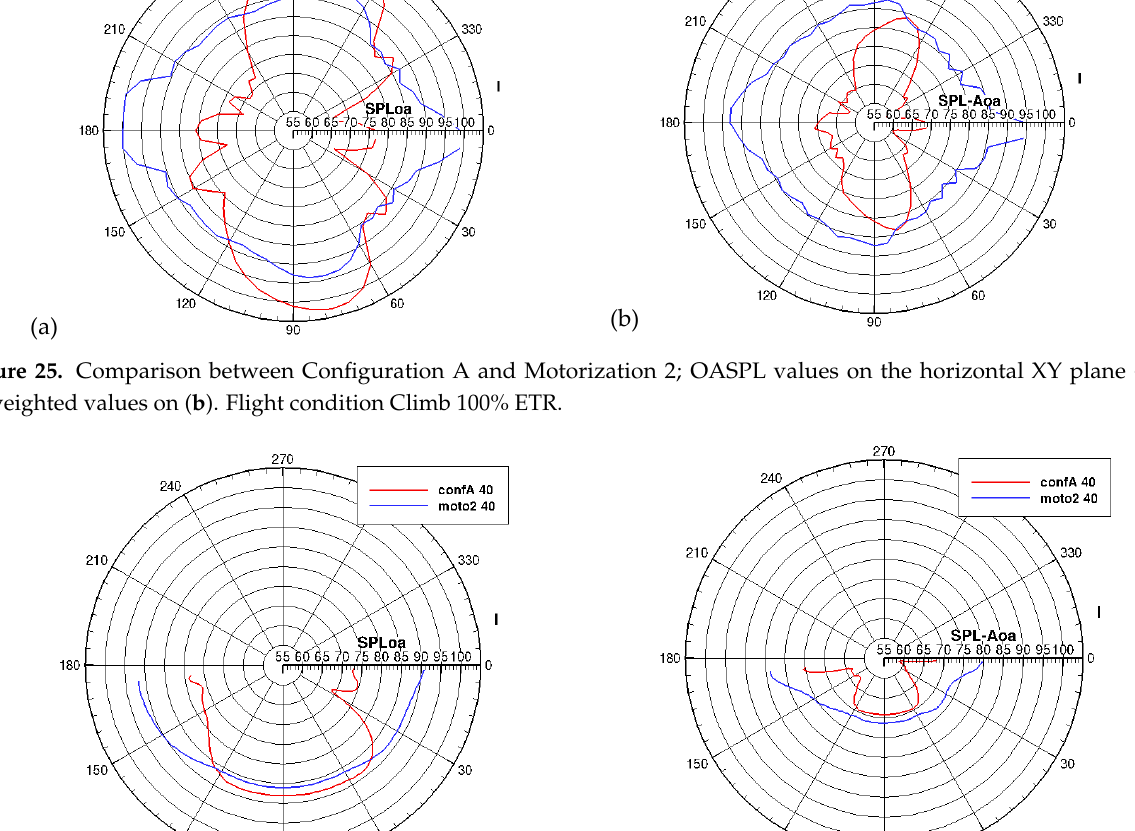
Figure 26. Comparison between Configuration A and Motorization 2; OASPL values on longitudinal XZ plane ( a ), A-weighted values on ( b ). Flight condition Descent 40% ETR.